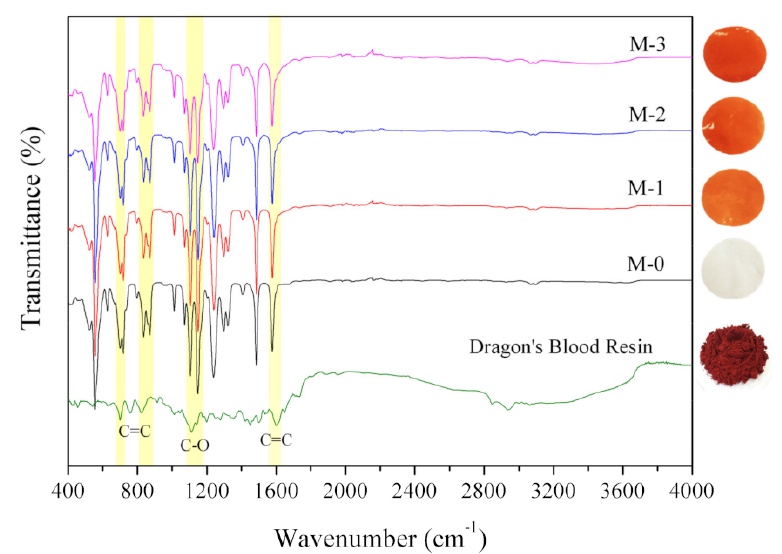
Figure 2. FTIR spectra of the DBR powder and the membrane samples. The insets show the appearance of the membrane samples resembling the uniformly distributed DBR